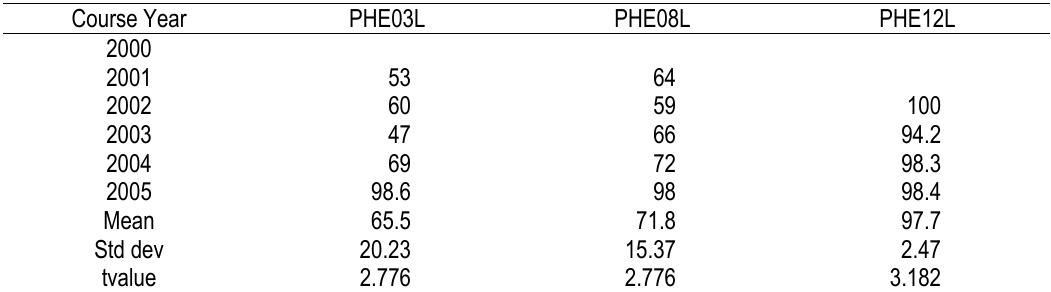
Table 4. Success Rates in Physics Laboratory Courses in the Period 2000-2005 Course Year PHE03L